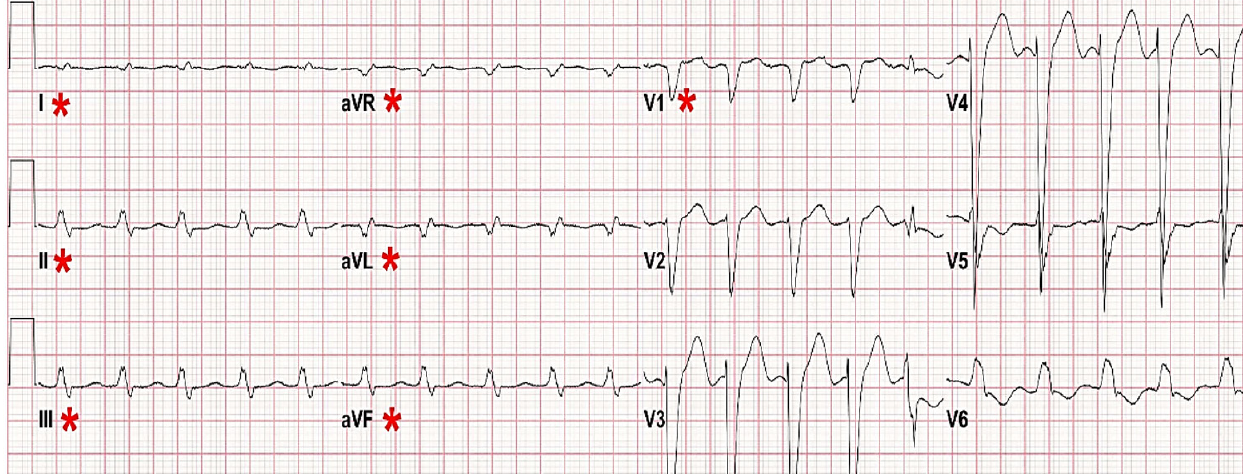
100 beats/min in a patient with a ventricular paced rhythm. Figure from the ECG Monitoring Research Lab, UCSF School of Nursing. The Pacer Mode feature was not turned on (star) in this patient, which led to non-stop false AVR alarms.